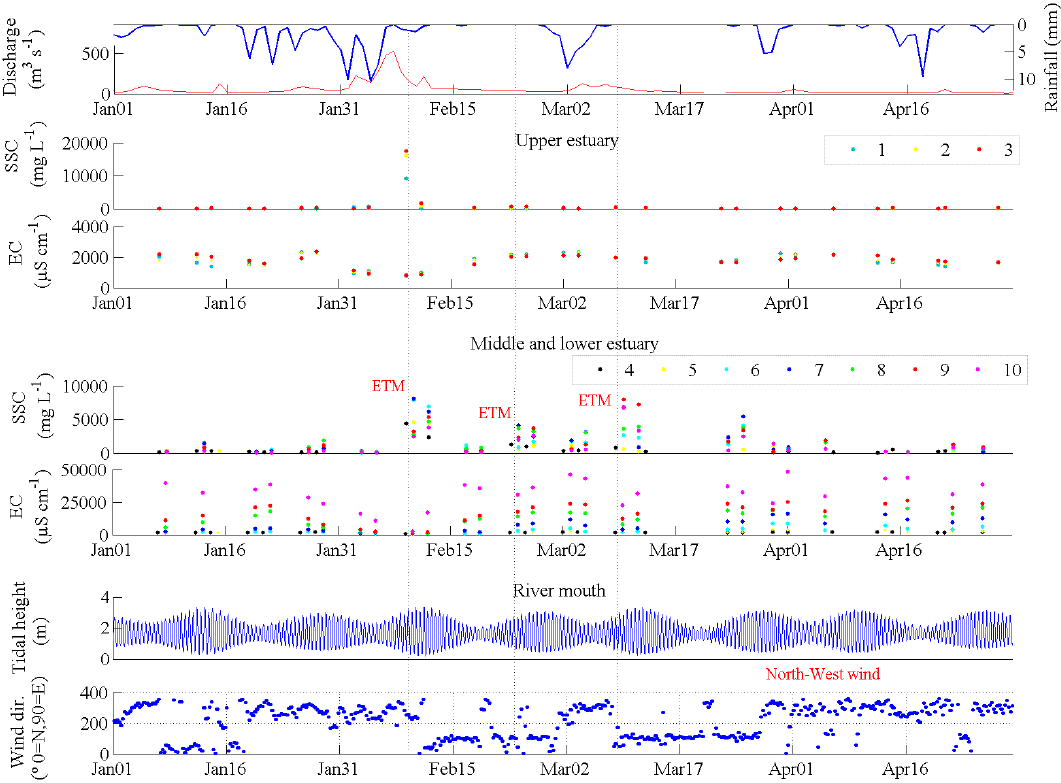
Fig. 5. Mean daily rainfall in the basin upstream of the estuary, daily discharge from the Alcal´a del R´ıo dam, SSC and EC in the upper, middle and lower estuary, tidal height and wind direction in the river mouth, period January–April